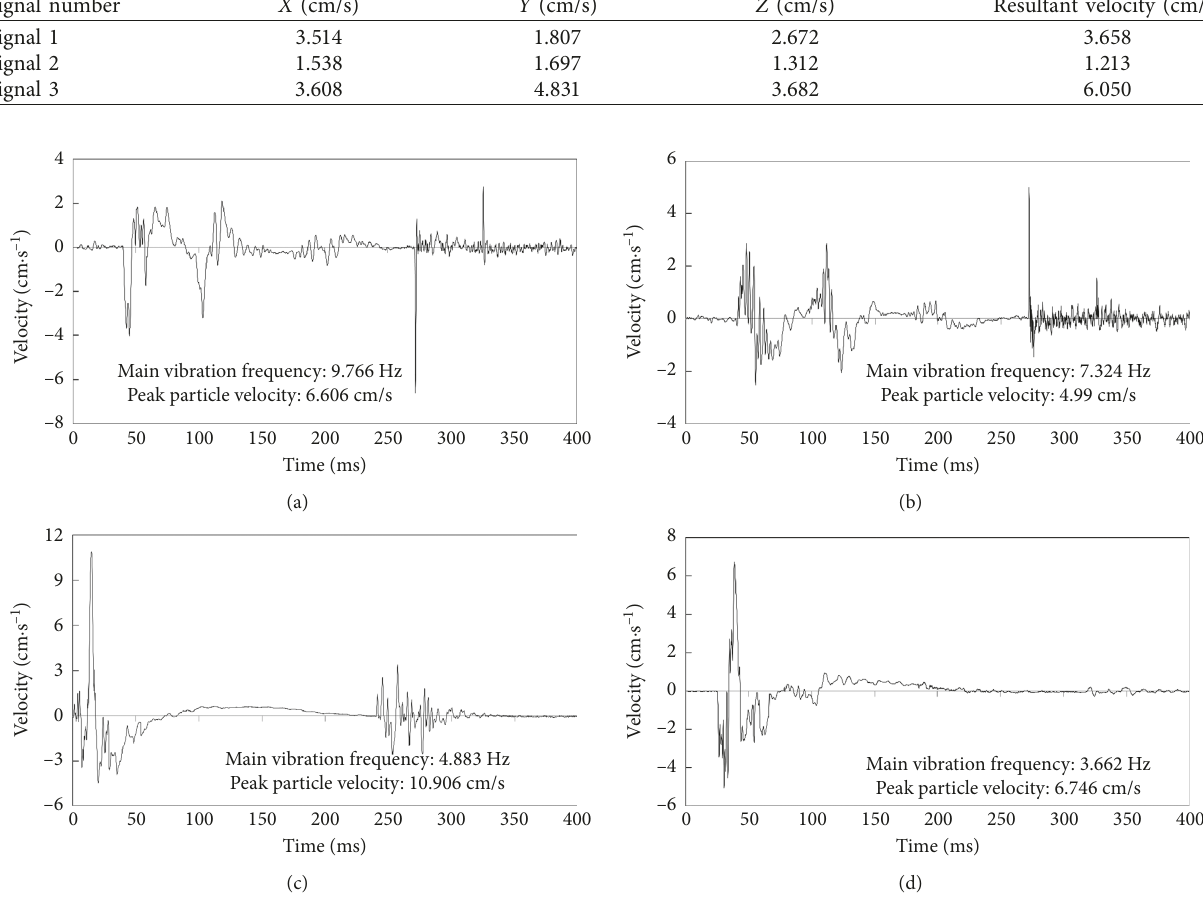
Figure 9: Velocity-time curves of partial measured blasting vibration signals.